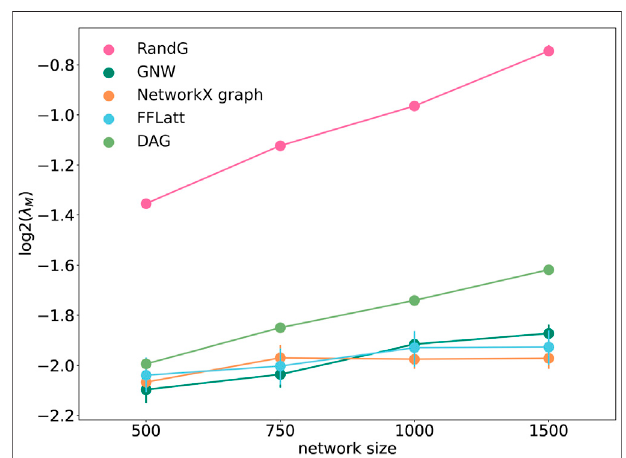
FIGURE 7 | Stability of randomly wired simulated network graphs. λ is the lowest eigenvalue of the interaction matrix M . Each data point was calculated as the average of ten different repeats of overlaying links chosen randomly with strengths from a standard distribution, with correspondingsemi-transparentareasindicatingthe95%con fi denceinterval.